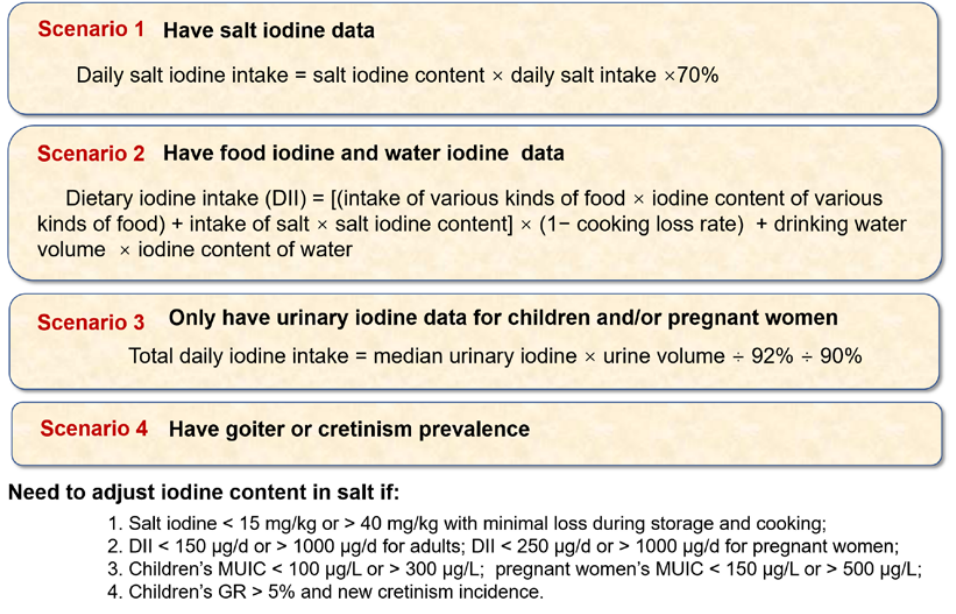
Figure 3. Selection plans for the iodine content in salt for different countries. GR, goiter rate; MUIC, median of urine iodine concentration.